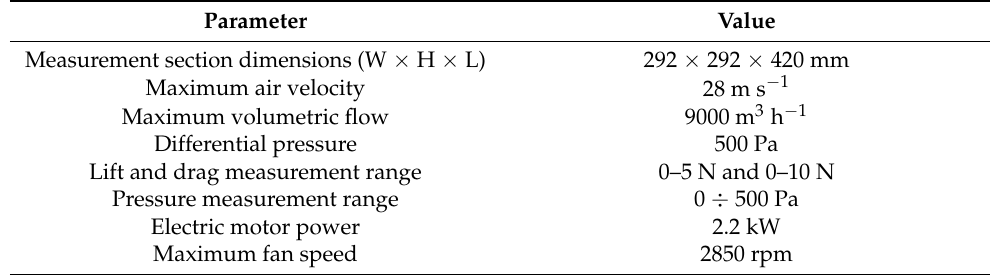
Table 1. Selected technical parameters of the Gunt HM 170 wind